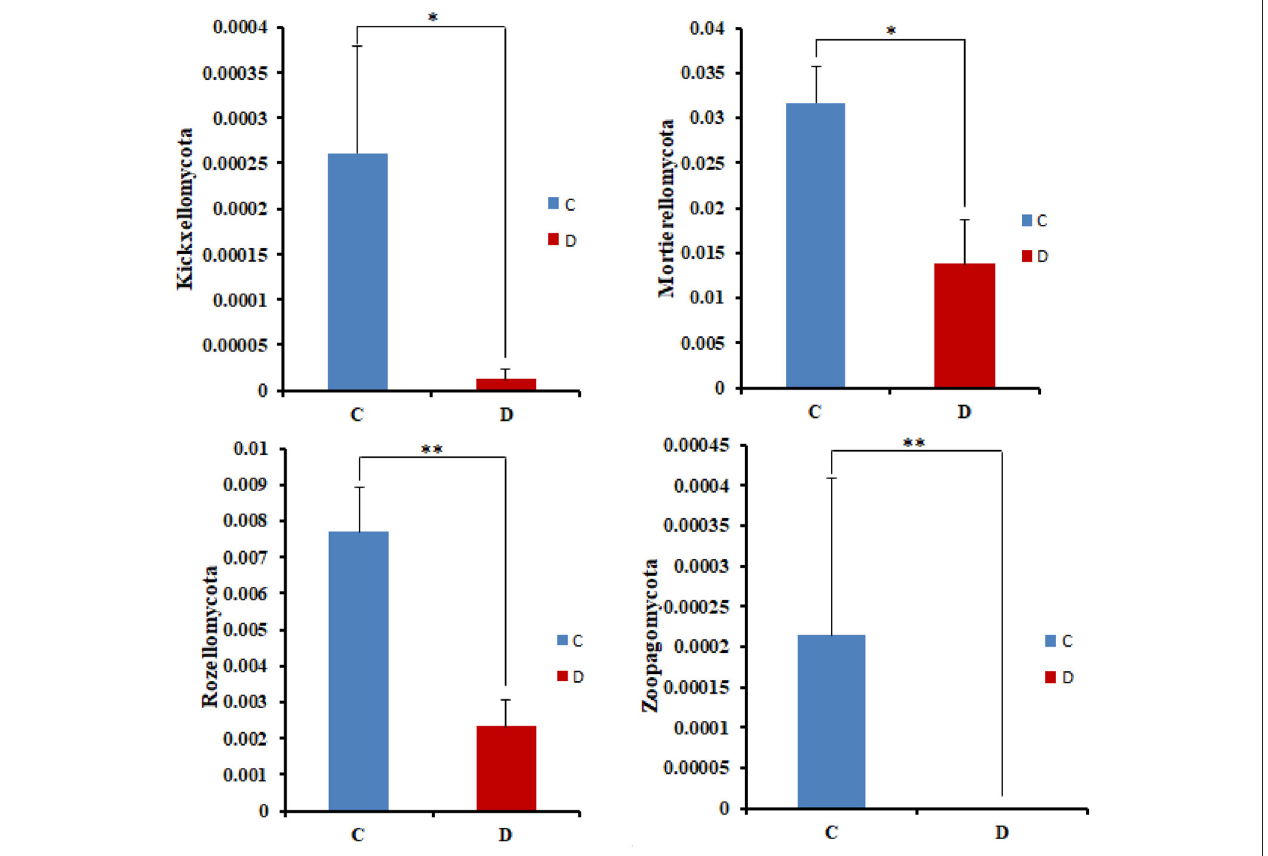
FIGURE 6 | Comparison with the fungal community structure at phylum level in the two groups. * p < 0.05, ** p <